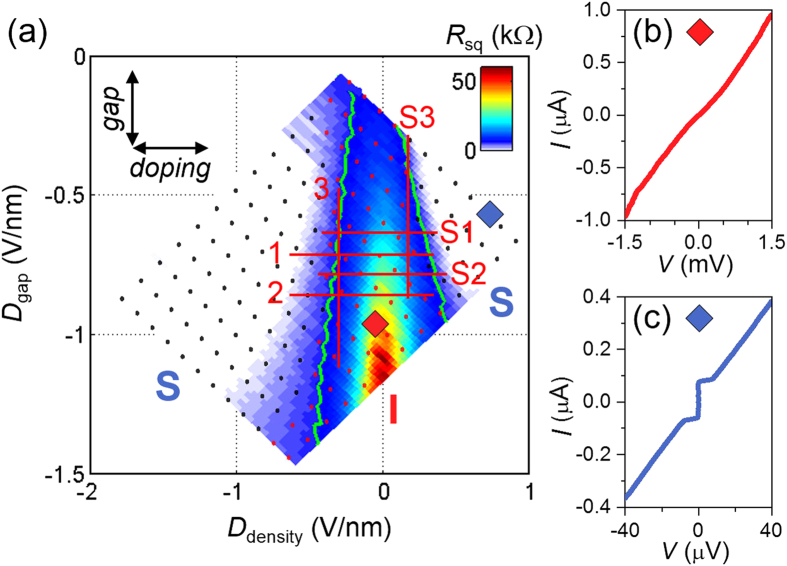
Insulating and superconducting states in an electron-hole puddle system.(a) Color-coded square resistance map of the junction as a function of Ddensity and Dgap measured at 50 mK. The diamond symbols indicate representative insulating (red) or superconducting (blue) points of Ddensity and Dgap. The green contours correspond to the quantum resistance of Cooper pairs, RQ = h/4e2, and separate insulating regions from the superconducting regions. The red curves indicate gate sweep traces 1–3 and S1–S3. Current–voltage characteristics taken at the corresponding points denoted in (a) exhibit (b) a nonlinear insulating behavior (the red curve) and (c) zero-resistance superconducting behavior (the blue curve).